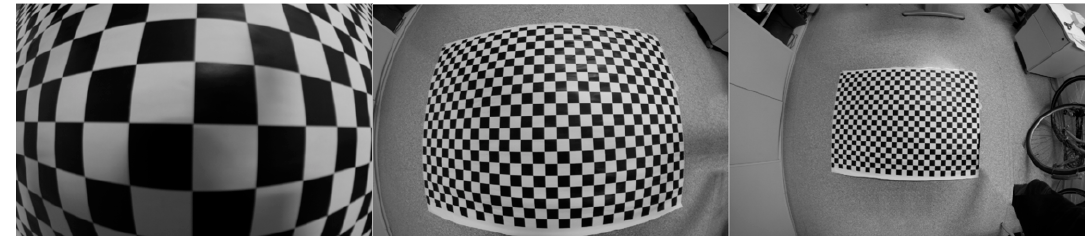
Figure 4. Checkerboard images taken at different camera-template distances. Checkerboard plane is as parallel as possible of the image plane. This guaranties that all control points are in the same camera-object distance and a unique valid distortion model represent them.